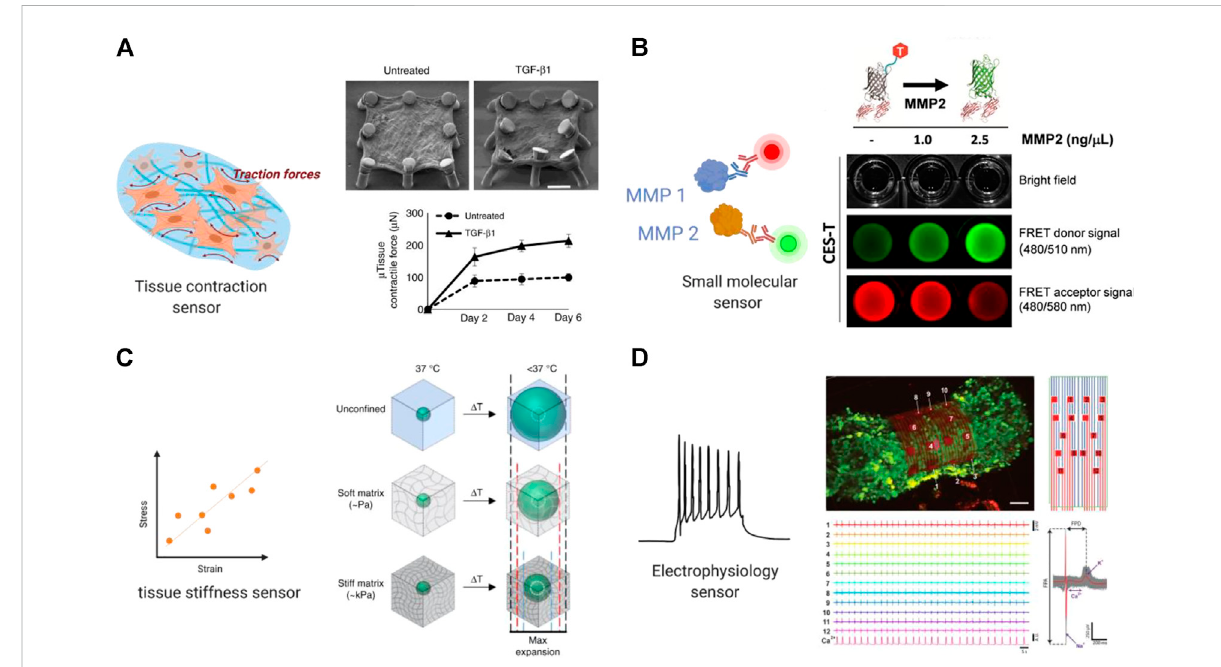
FIGURE 3 Built-in biosensors for anti- fi brotic drug screening. (A) Micropillar sensors integrated in a membranous human lung microtissue array to measure spontaneous contraction force generated by fi brotic tissues (Asmani et al., 2018). Reproduced under terms of the CC-BY license. (B) A microgel-basedbiosensorforthedirectmeasurementofmechanicalstiffnessinlocaltissues(Moketal.,2020).ReproducedundertermsoftheCC- BYlicense. (C) AnextracellularFRET biosensorfor thevisualizationofMMP2 activityina3Dculturesystem(Leeetal.,2020).Reproduced under termsoftheCC-BYlicense. (D) Aself-rolledbiosensorarraytoinvestigateelectrogeniccellbehaviorin3Dhumancardiacspheroids(Kalmykovetal.,